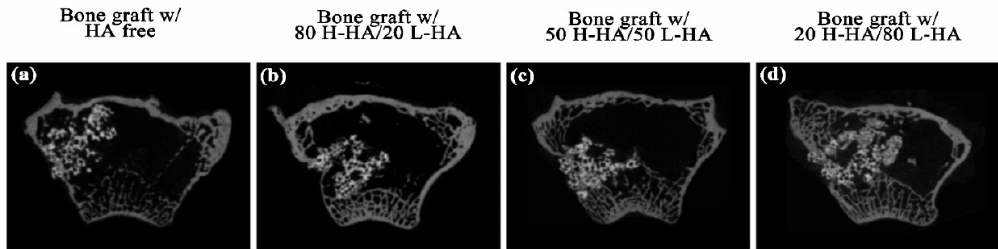
Figure 4. Micro-CT transversal section images of the tested artificial defects grafted with ( a ) HA-free hydroxyapatite/ β -TCP bone graft and bone graft combined with HA hybrid at H-HL/L-HA ratios of 80:20 ( b ), 50:50 ( c ) and 20:80 ( d ) after 12 weeks of healing.